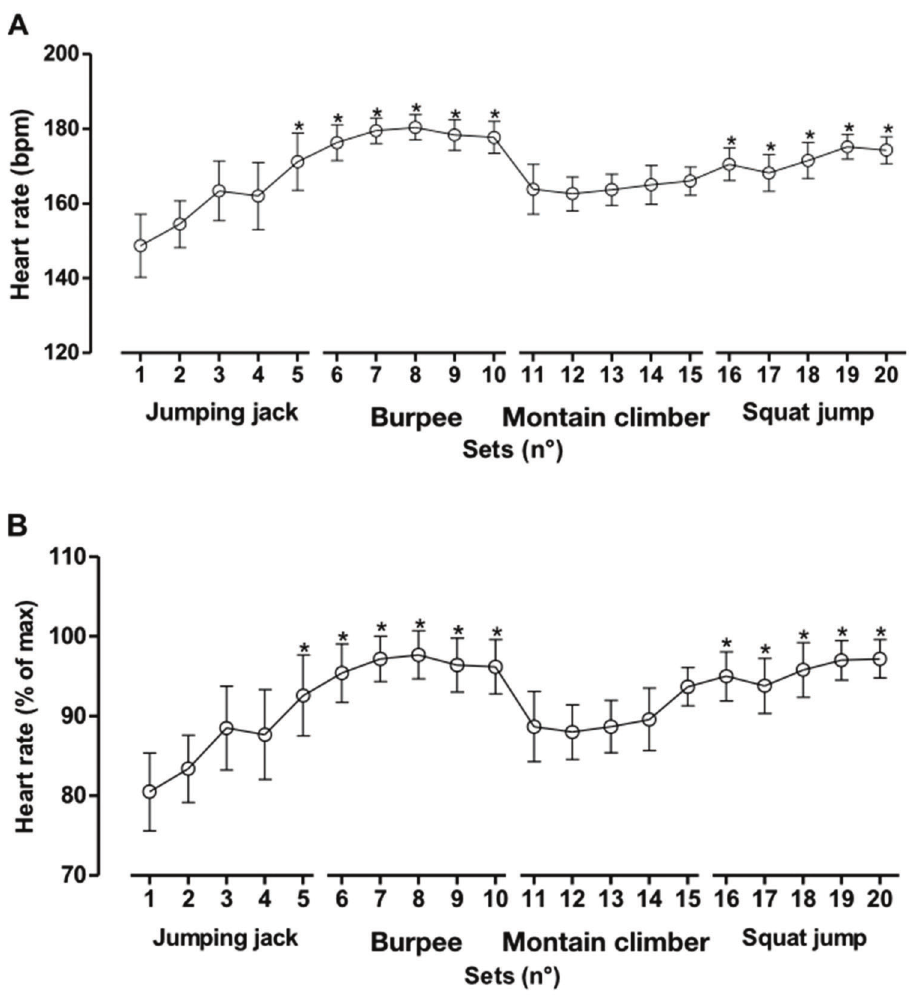
Figure 3 - Values are presented as the means ± standard deviations. Panel A: absolute heart rate. Panel B: relative heart rate (% of max). * p o 0.001 vs . the first set.